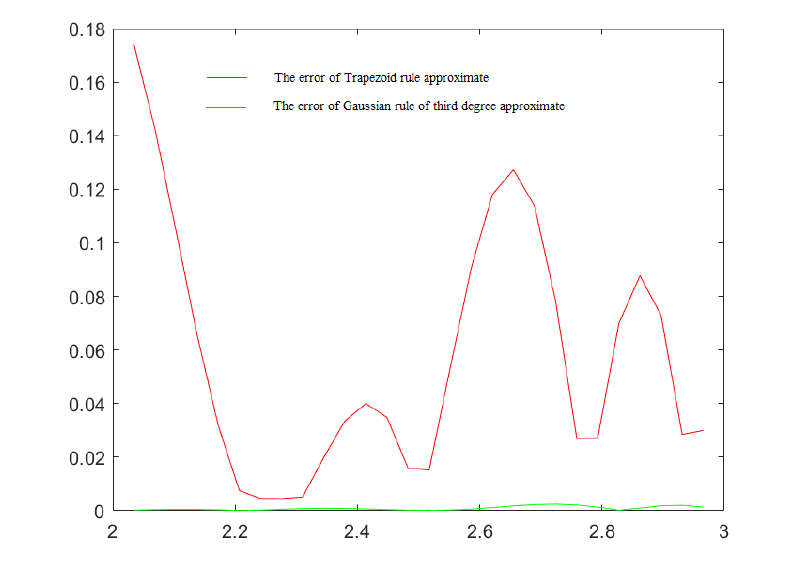
Figure 4. Error functions of two approximations of the original function in Example 3, given by inverse F 2 -transforms calculated using the trapezoid and the suggested quadratures. In the latter case, the errors are practically equal to